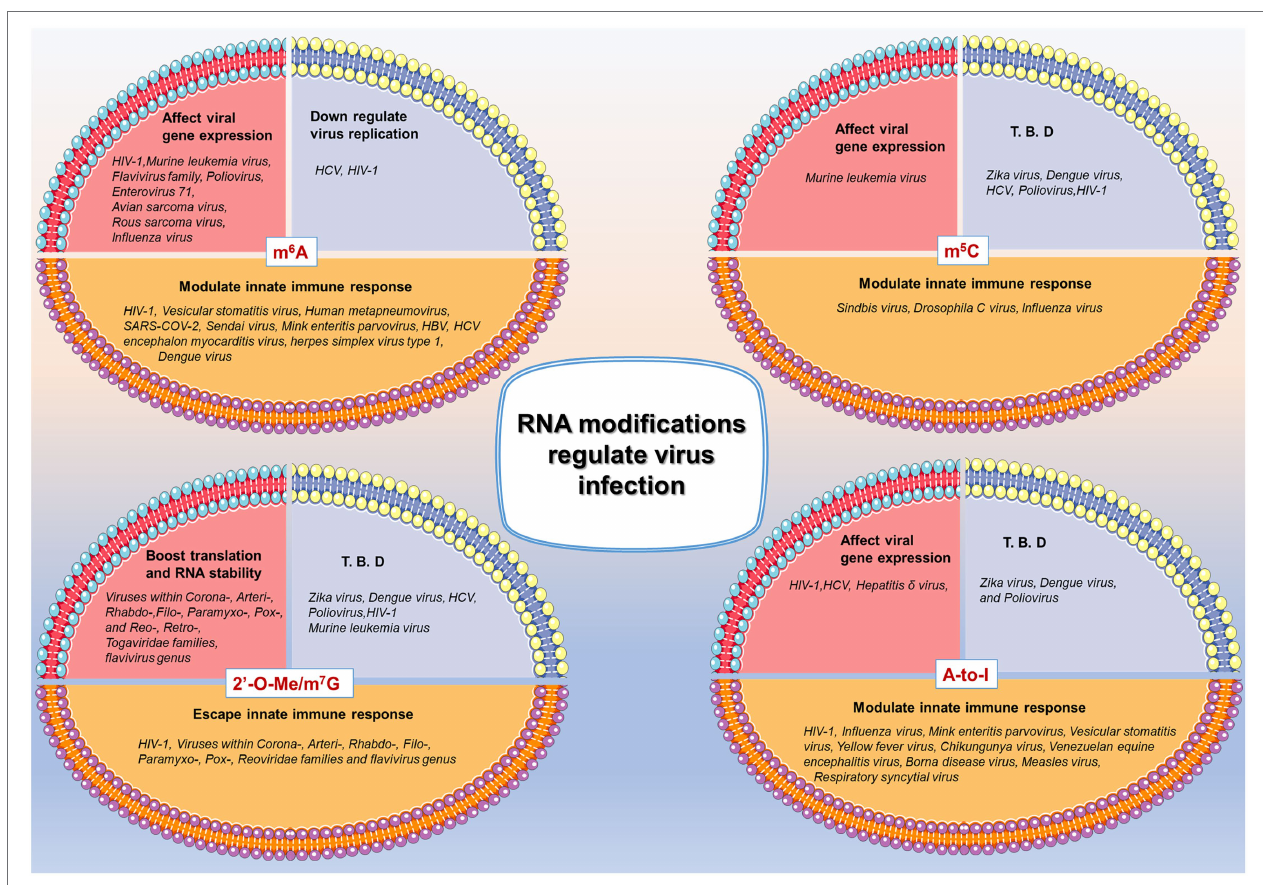
FIGURE 1 | Brief summary of RNA modifications in regulating virus infection. N6-methyladenosine (m 6 A), 5-methylcytidine (m 5 C), 2 ʹ -O-methylation (2 ʹ -O-Me)/7- methylguanosine (m 7 G), and A-to-I editing (A-to-I) are listed as example of epigenetic regulations in virus infection. Three major effects are summarized in diverse virus infection, among which the modulation of innate immune response is the focus of the present review. T. B. D: To be determined. References are listed in the Supplementary Table S1